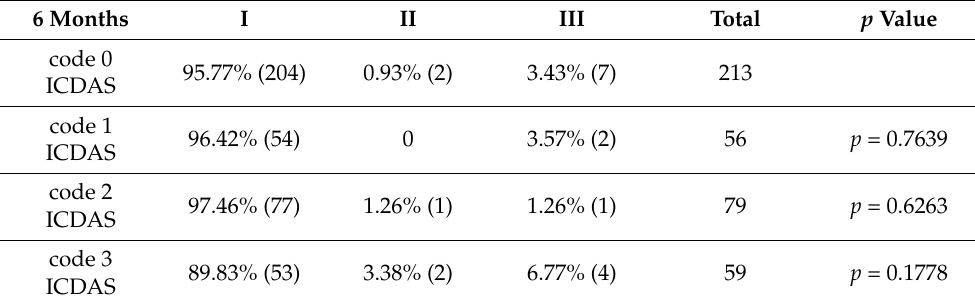
Table 2. Retention based on Simonsen’s criteria at the 6-month follow-up.